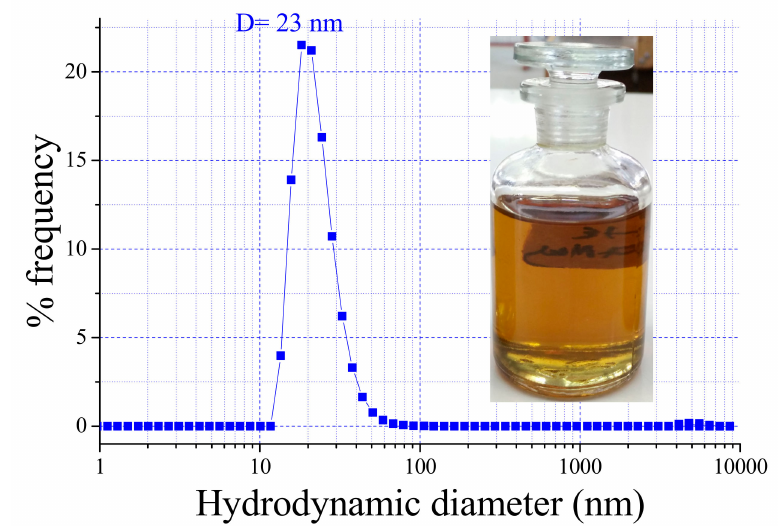
Figure 1. Size distribution diagram based on dynamic light scattering measurement of the colloidal magnetic iron oxides nanoparticles (MIONs) in the oil matrix and digital image colloidal nanofluid (colNF) after 2 months of storage (inset).